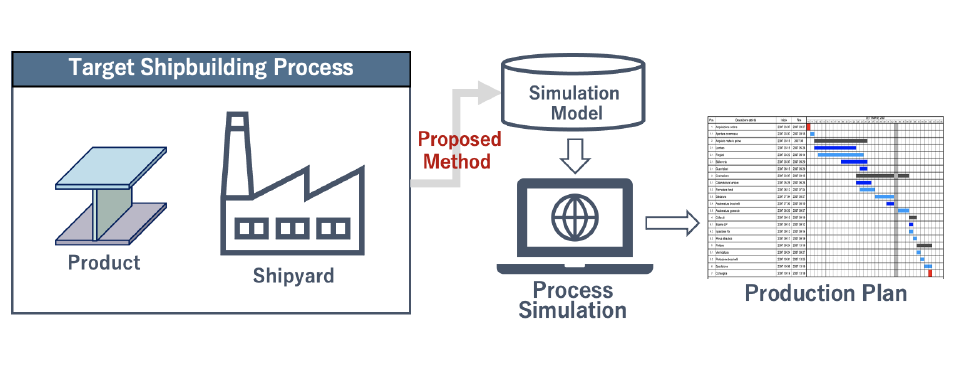
Figure 1. Overview of the Proposed